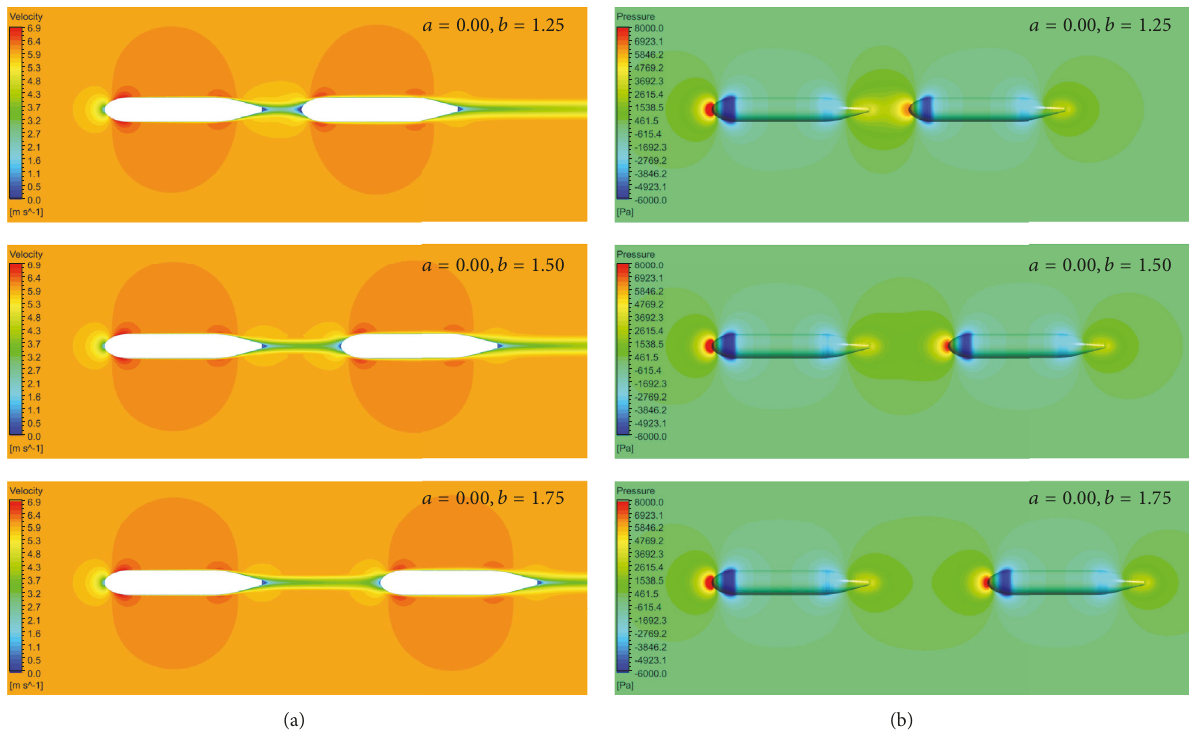
Figure 12: Contours of (a) velocity and (b) pressure around two parallel AUVs at different latitudinal offsets.